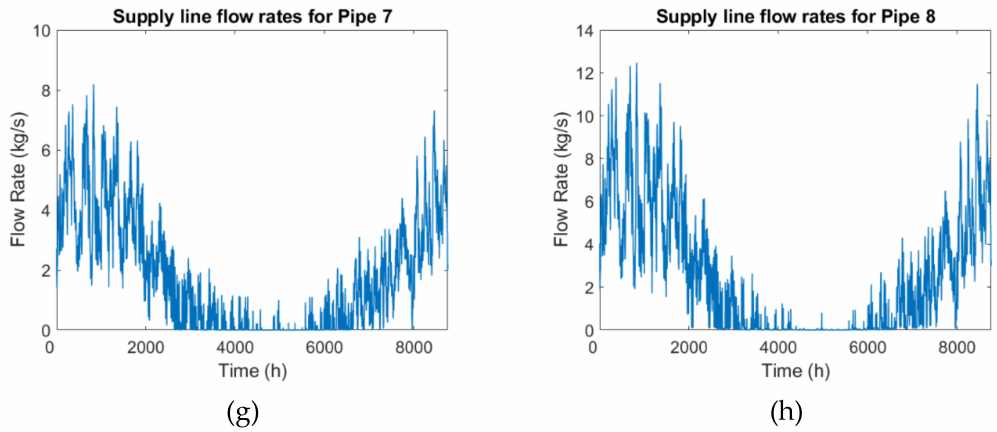
Figure 7. Supply line mass flow rates for the heating system in ( a ) Pipe one; ( b ) Pipe two; ( c ) Pipe three; ( d ) Pipe four; ( e ) Pipe five; ( f ) Pipe six; ( g ) Pipe seven; ( h ) Pipe eight.